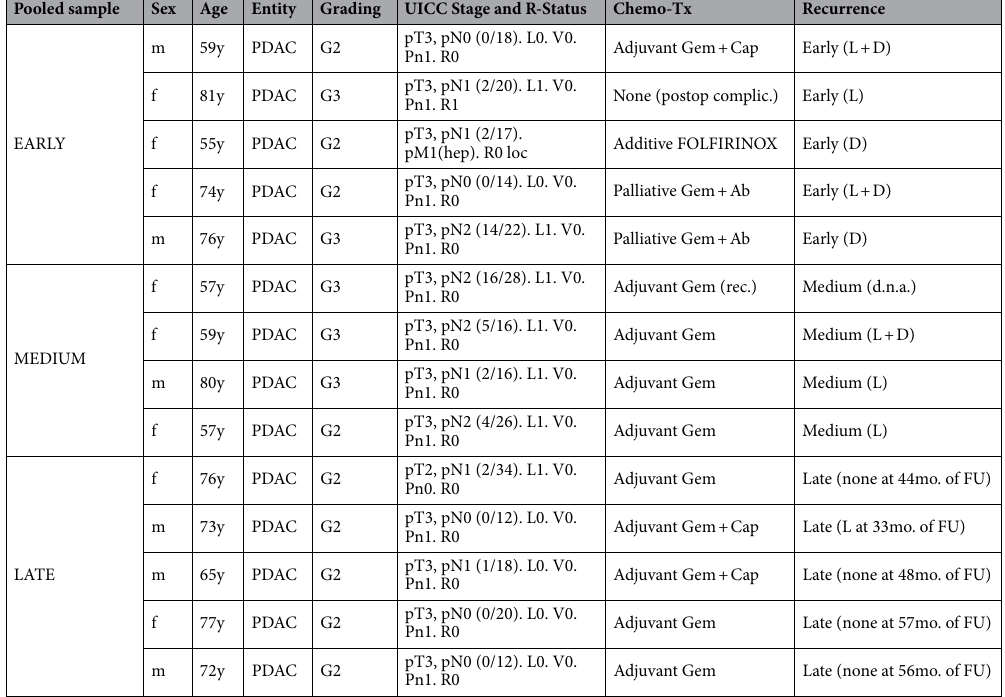
Table 1. Clinicopathological data of patients who provided plasma samples analyzed in this study. d.n.a. : data not available; Gem : gemcitabine; Ab : nab-Paclitaxel; Cap : Capecitabine; Early : tumor recurrence within the first 6 months after curatively intended resection; Medium : tumor recurrence within 6–12 months after resection; Late : no tumor recurrence even 12 months after resection; L : local recurrence, D : distant recurrence (hepatic/ pulmonal/peritoneal carcinomatosis); FU :